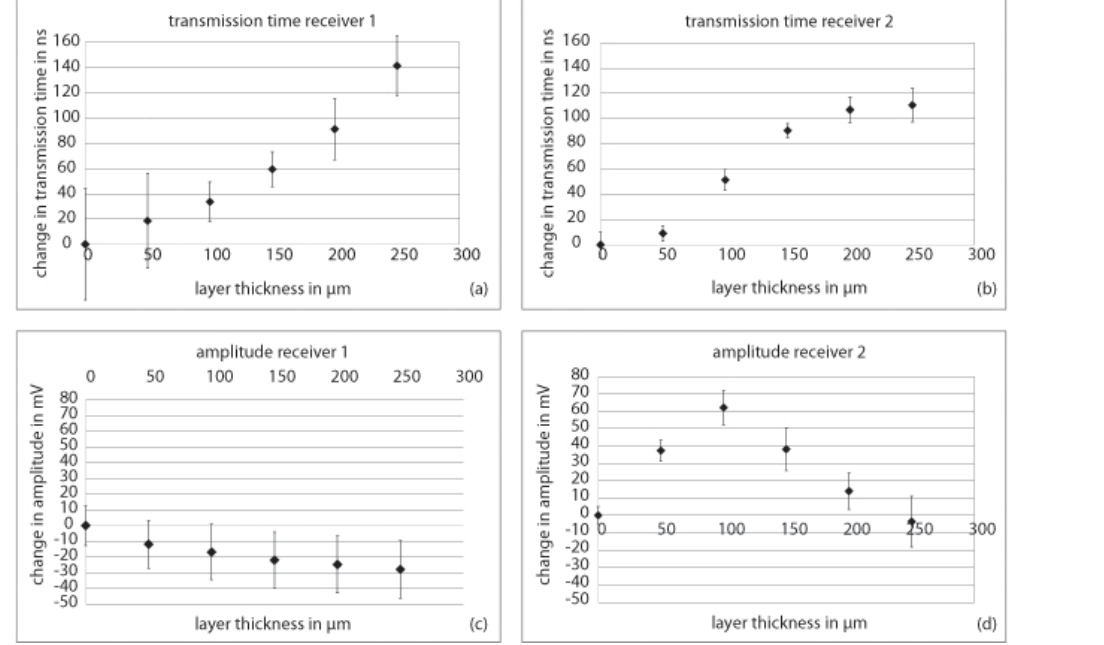
Figure 19. Measurement results for the changes of the transmission times and of the amplitudes on the two receivers for increasing adhesive tape thickness in the stainless steel